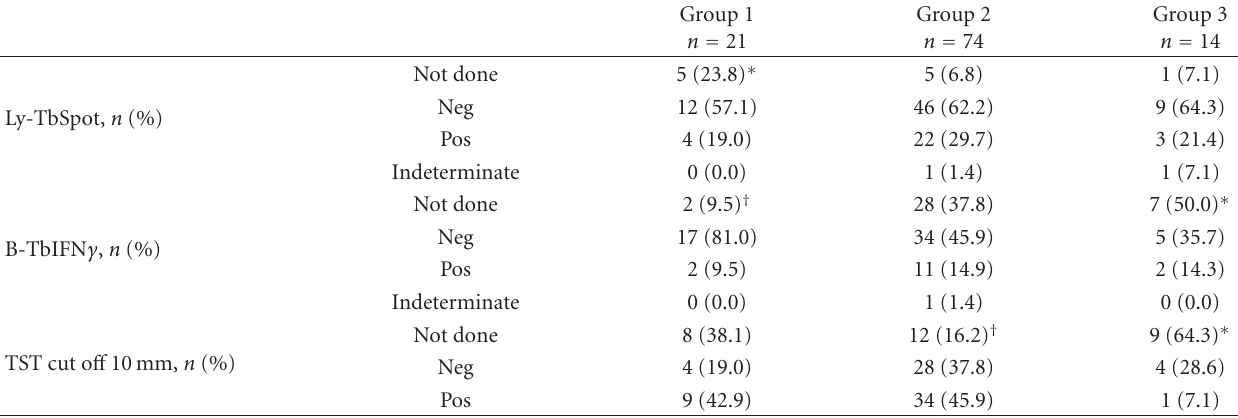
Table 2: Number of tests performed to the study population.